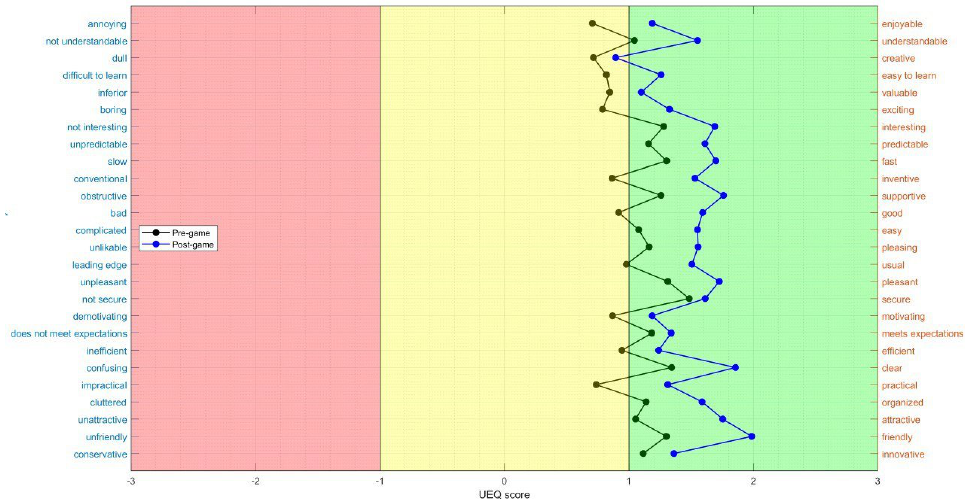
Figure 5. User Experience Questionnaire: responses from study